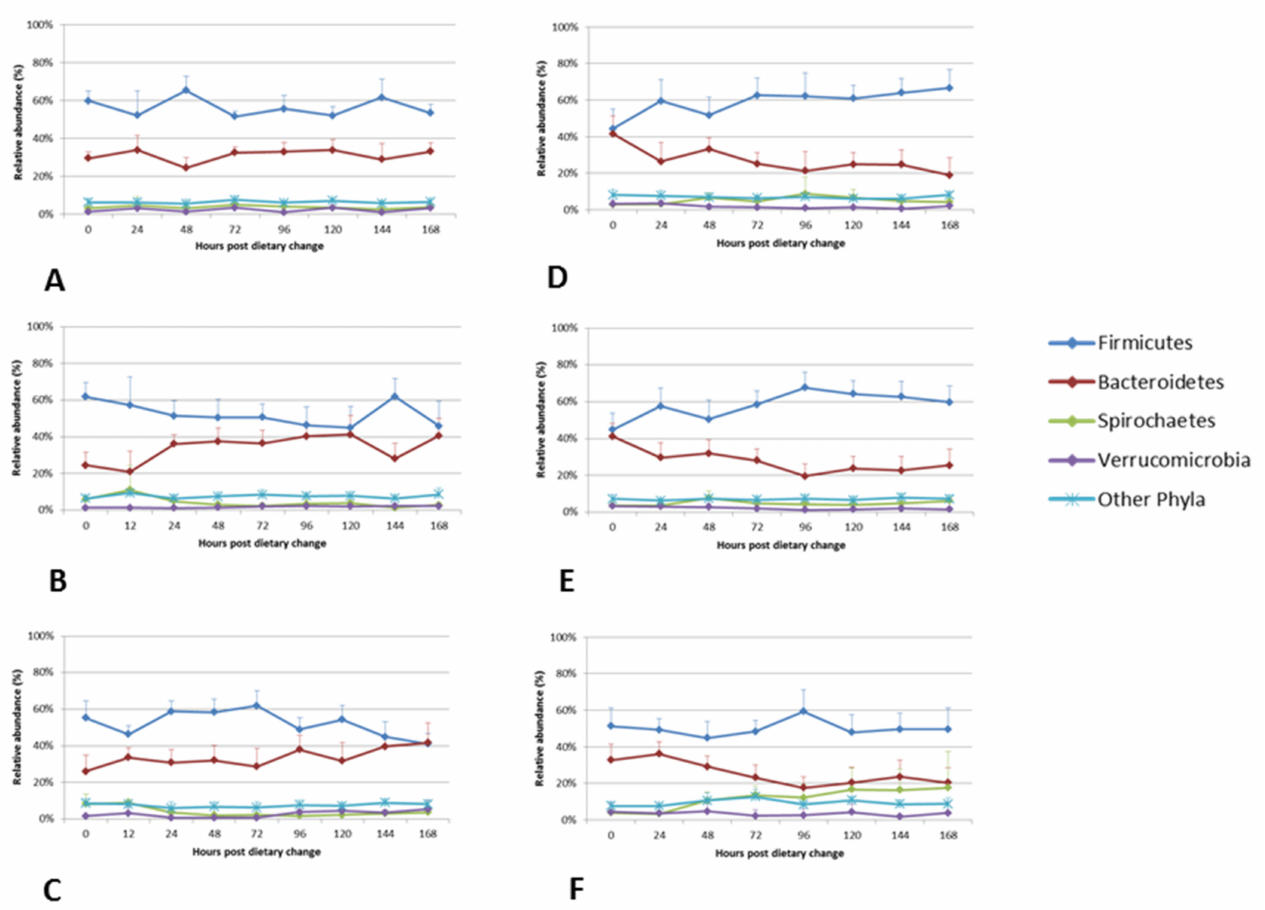
Figure 4. Comparison of the relative abundance of the four most dominant faecal bacterial phyla from 0 to 168 h following dietary change. Mean relative abundances of the four most dominant phyla that comprise the faecal bacterial community of the six horses included in the study are shown in the line graphs. Each panel represents a dietary treatment block. Panel A) Diet P1- cut pasture; Panel B) Diet P2 – cut pasture; Panel C) Diet P3 – cut pasture; Panel D) Diet FE - chopped ensiled Lucerne and Timothy; Panel E) Diet FE+O - chopped ensiled Lucerne and Timothy fed with whole oats; Panel F) Diet H+O - hay fed with whole oats. The time points in hours following dietary change are shown on the x-axis of the primary graph in each panel. Error bars represent the standard deviation (only positive